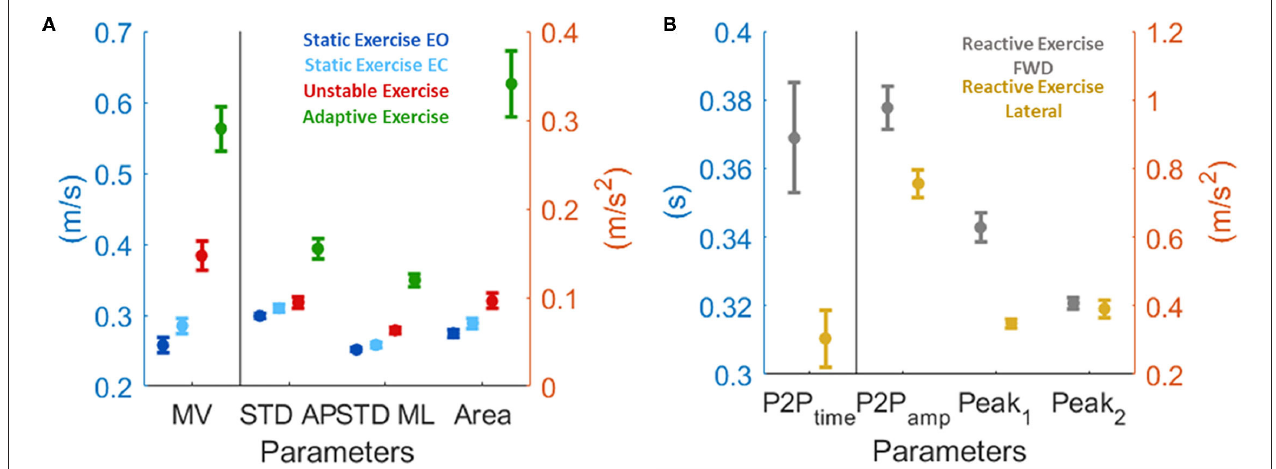
FIGURE 5 | Motor performance of the subjects under 25 expressed as mean and standard deviation. This is the normalization factor we used before applying the fitting (see methods section for more details). (A) for test from 1 to 4, and (B) for test